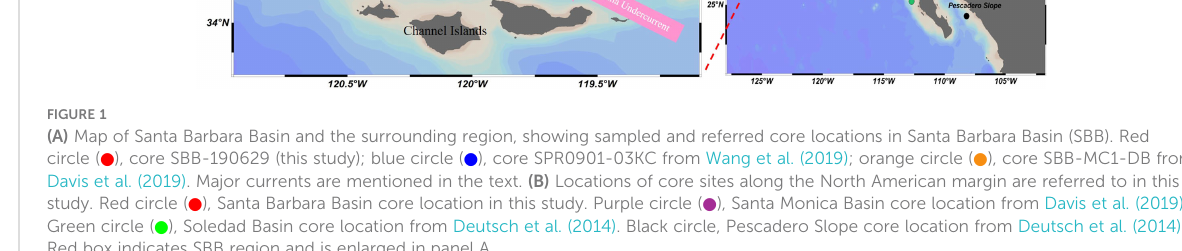
(Figure 1A). The ETNP has the largest volume of low-O 2 waters of all ODZs along the equator to mid-latitude in the northeastern Paci fi c (Horak et al., 2016); fl uctuations of the intensity of denitri fi cation in the ETNP are re fl ected on water d 15 N and advected to SBB. Compared with the denitri fi ed water from ETNP, CC input with lower d 15 N is considered a relatively stable end-member on decadal scales in the nitrogen isotopic mass balance of the SBB input water. Therefore, in this study, the ETNP d 15 N variation represents the distal signal (or remote forcing) in SBB d 15 N budget. Finally, the SBB bottom waters (>475 m) are derived from North Paci fi c Intermediate Water (NPIW), which periodically fl ows over the deepest sill and further complicates the water column oxygen content and denitri fi cation in SBB.